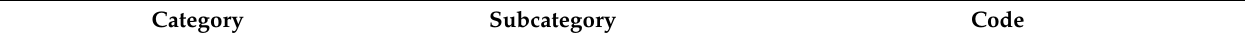
Table 1. Overview of categories, subcategories and codes merged from narrative data in the qualita- tive content